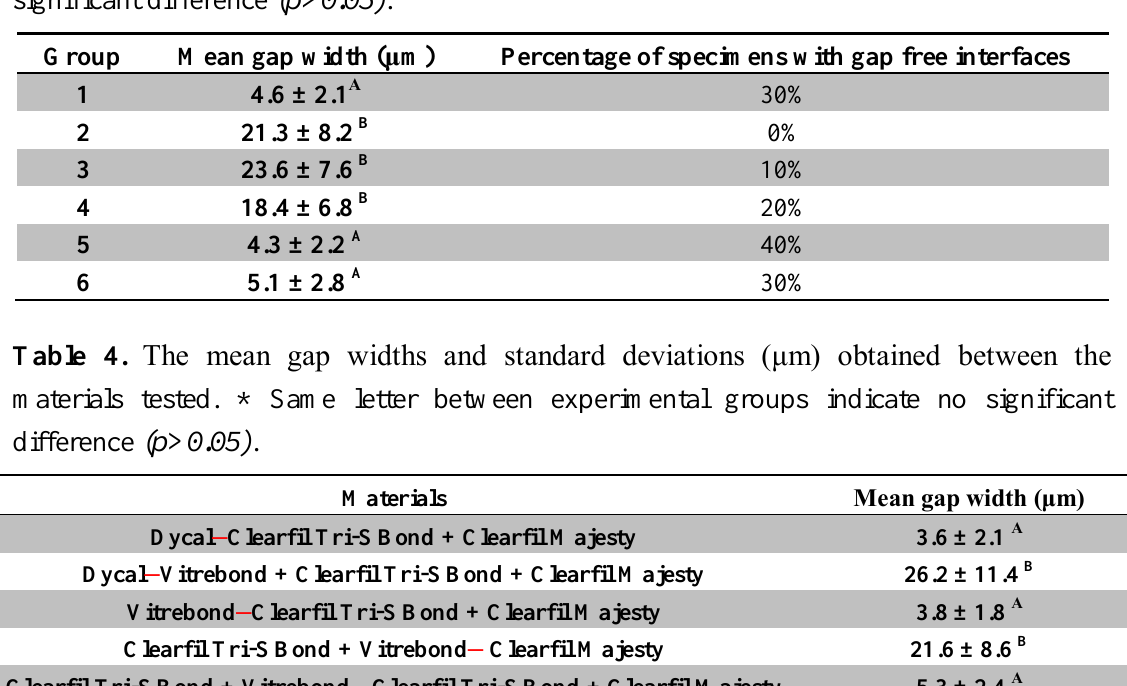
Table 3. The mean gap widths and standard deviations (μm) obtained from each experimental group between dentin and the materials tested and the percentage of specimens with gap free interfaces.* Same letter between experimental groups indicate no significant difference (p>0.05) .